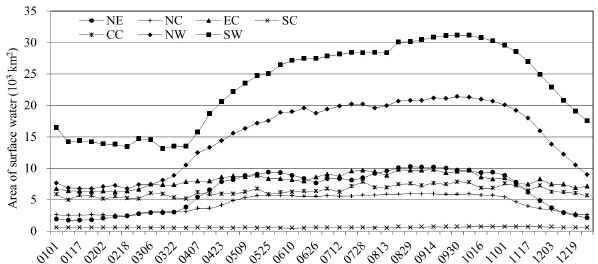
Figure 7. The 8d surface water area in different regions of China from 2000 to 2016. NE: Northeast China, NC: North China, EC: East China, SC: South China, CC: Central China, NW: Northwest China, SW: Southwest China.